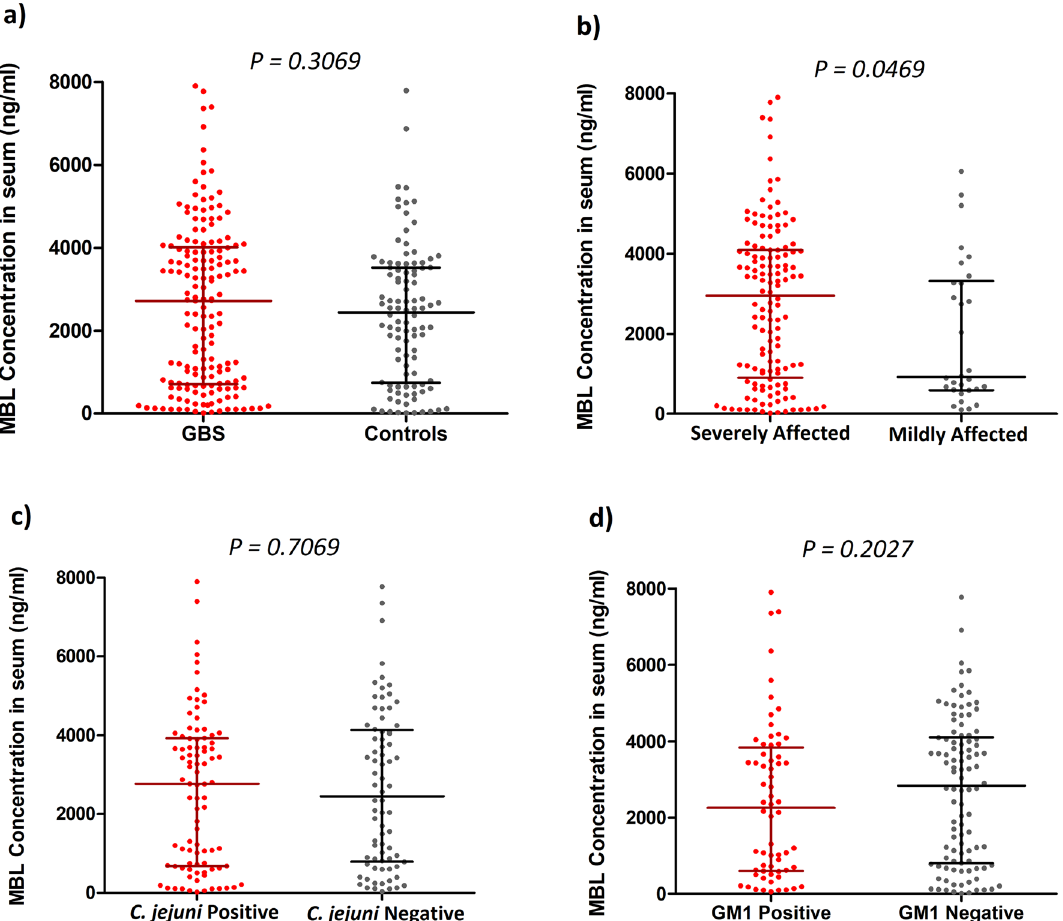
Figure 1. Serum levels of MBL among different subgroups of patients with GBS and healthy controls. Comparisons between ( a ) GBS patients and controls, ( b ) severely affected and mildly affected patients with GBS, ( c ) C. jejuni -positive and -negative patients with GBS, and ( d ) anti-GM1 antibody-positive and -negative patients. The thick horizontal black lines indicate the median serum MBL value and the vertical lines indicate the IQR; * P < 0.05, Mann–Whitney U